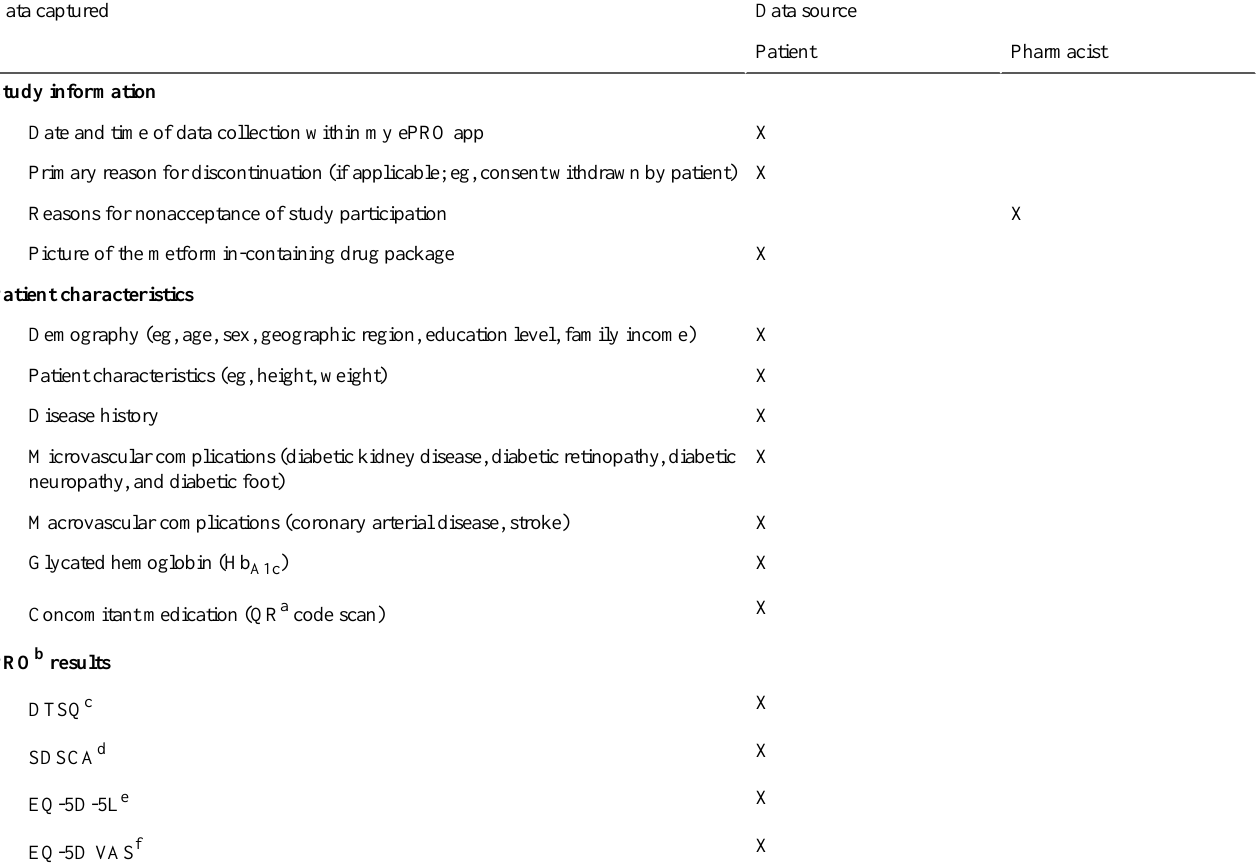
Table 1. Data captured within DePRO study by